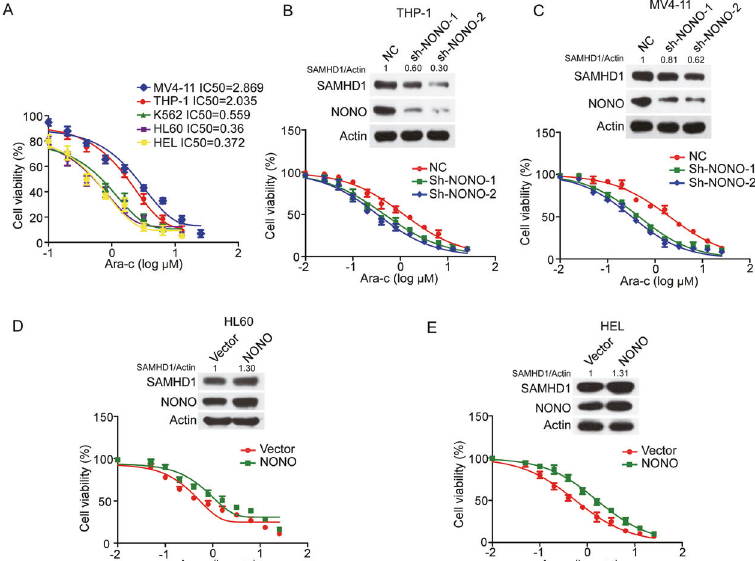
Fig. 5 NONO affects the sensitivity of AML cells to Ara-C. A IC50 values of Ara-C in AML cell lines. AML cells (1 × 10 5 cells/well) plated in 24- well plates were incubated for 24 h and were then treated with a series of concentrations of Ara-C for 48 h. Cell viability was evaluated by a CCK-8 assay ( n = 3, mean ± SD). B , C Silencing NONO increased the sensitivity of AML cells to Ara-C. THP-1 and MV4-11 cells with stable knockdown of NONO were treated with different concentrations of Ara-C for 48 h, and cell viability was evaluated by a CCK-8 assay ( n = 3, mean ± SD). D , E Overexpression of NONO decreased the sensitivity of AML cells to Ara-C. HL60 and HEL cell lines with stable overexpression of NONO were generated and treated with different concentrations of Ara-C for 48 h. Cell viability was evaluated by a CCK-8 assay ( n = 3, mean ± SD). B – E , two-way ANOVA was used to compare the behavior of NONO-silenced or overexpressed and control cells. For respective immunoblots, the protein levels were quanti fi ed by ImageJ software. Cell Death and Disease (2022)